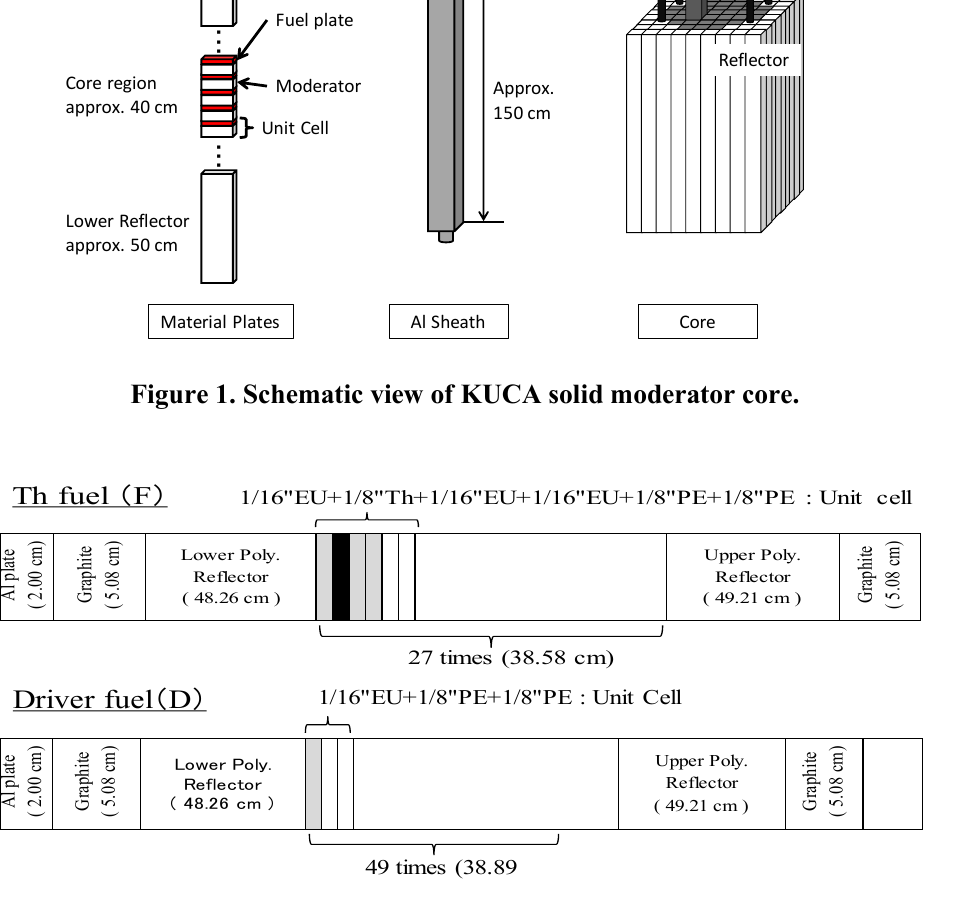
Figure 2. Configuration of Th fuel and Driver fuel